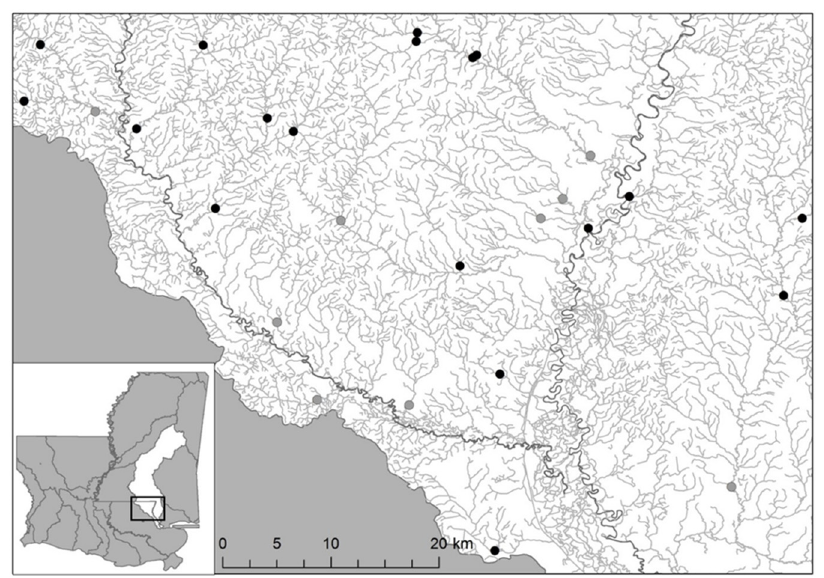
Figure 1. Tributary stream sites sampled during 2015 and 2016 in the Pearl River Basin, shown in white in the inset. Black circles represent sites sampled once. Grey circles on the map indicate sites that were re-sampled during the second sampling period.